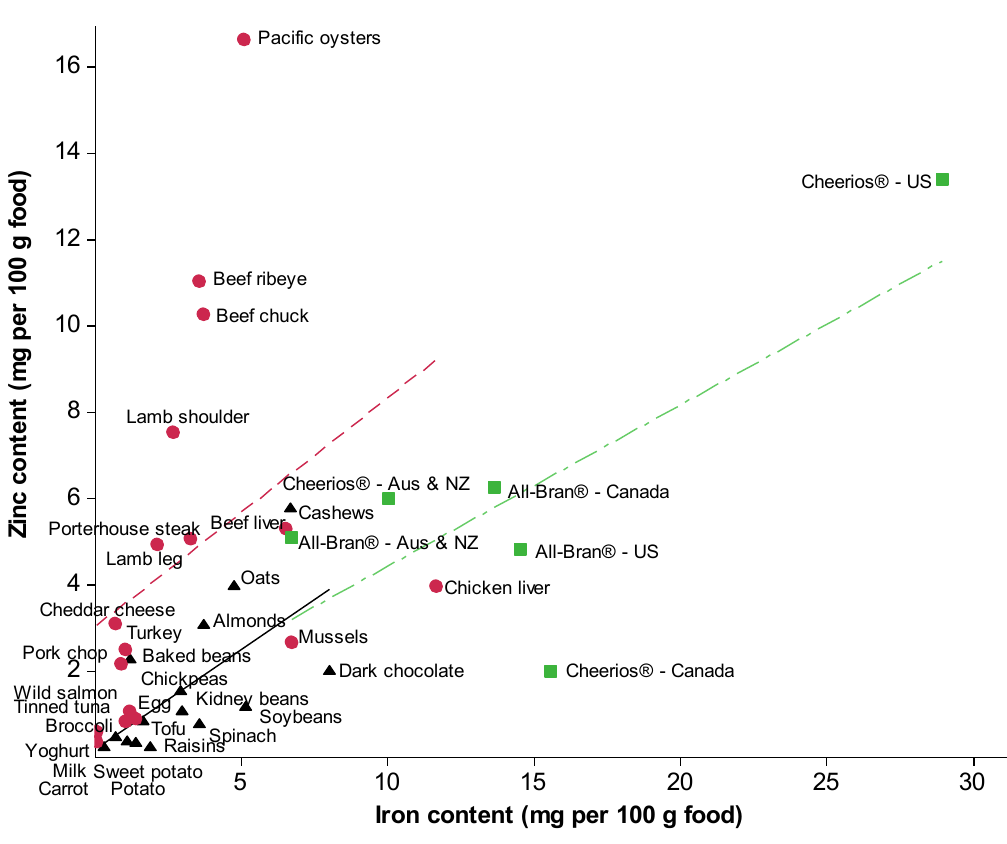
Figure 1. Relationship between dietary iron and zinc content of selected foods of plant origin (indicated by black triangles), foods of animal origin (indicated by red circles) (adapted from USDA National Nutrient Database [20]), and fortified breakfast cereals (indicated by green squares [15–19]). For foods of plant origin (black solid line): r = 0.68, P = 0.005. For foods of animal origin (red dash line): r = 0.71, P = 0.001. For fortified breakfast cereals (green dash-dot line): r = 0.87, P = 0.086. Significance does not change when the two outliers, Pacific oysters and US Cheerios ® , are omitted. Values are based on uncooked nuts, carrot, oysters, raisins, oats and dairy products, and plain breakfast cereals; all other foods are